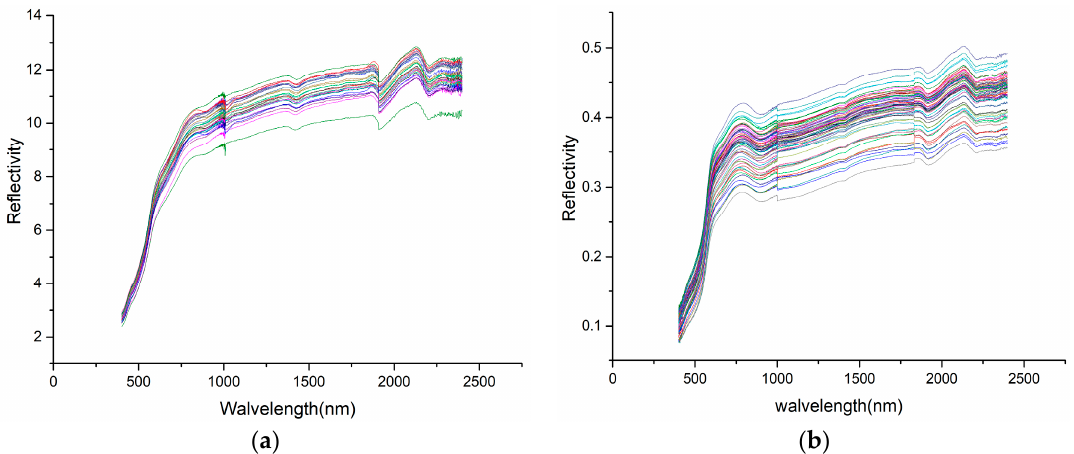
Figure 4. The spectra of the soil samples from the different regions. ( a ) Honghu. ( b ) Daye.